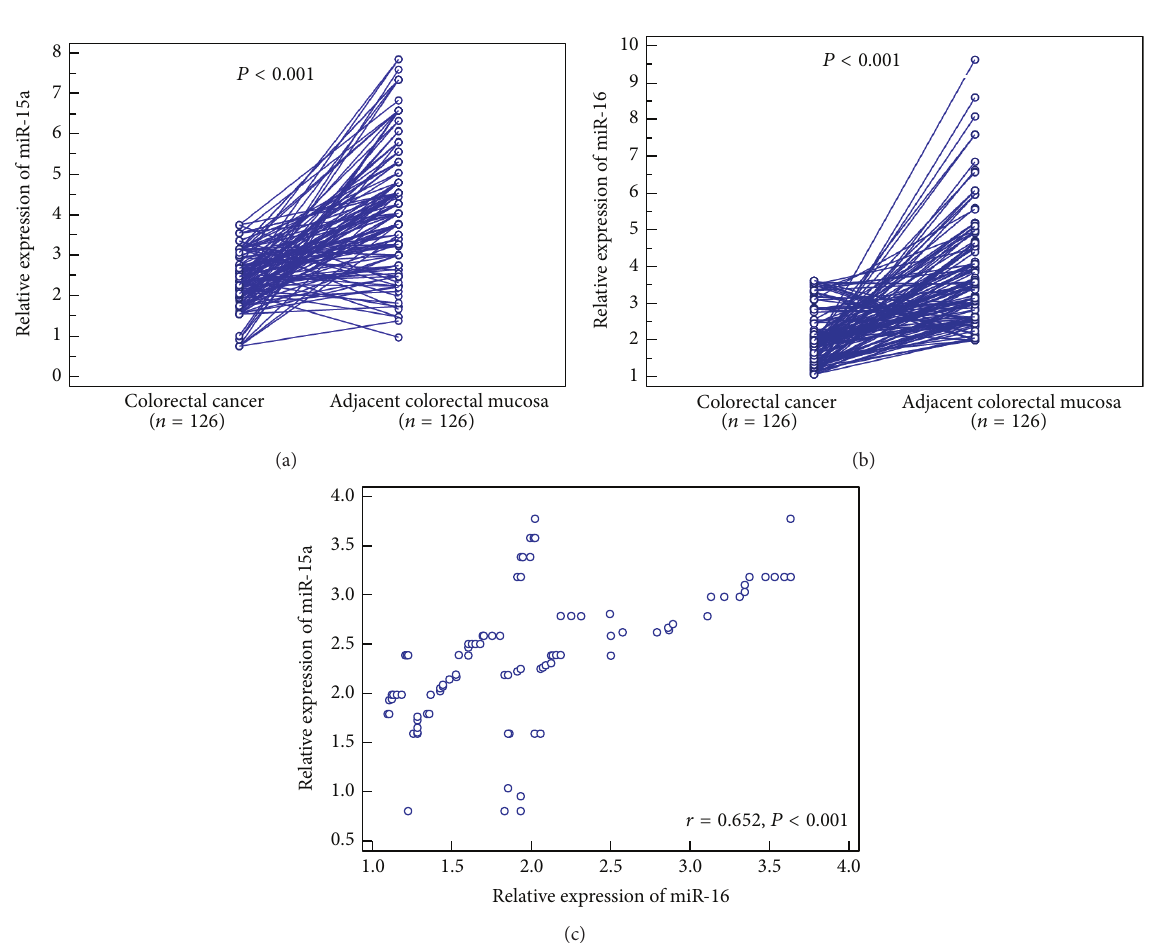
(miR-15a-high/miR-16-high), 23 (18.25%) were miR-15a-high and miR-16-low expression (miR-15a-high/miR-16-low), and 20 (15.87%) were miR-15a-low and miR-16-high expression